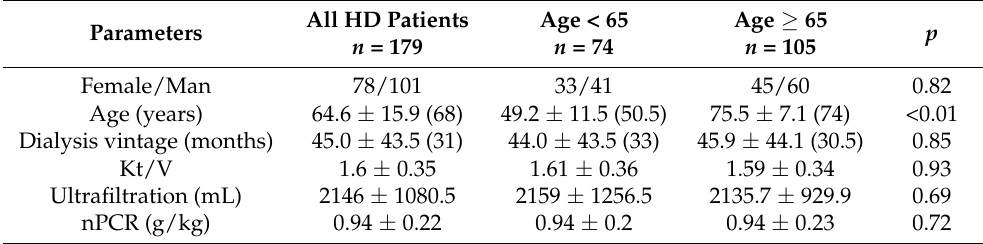
Table 1. Characteristics of the study